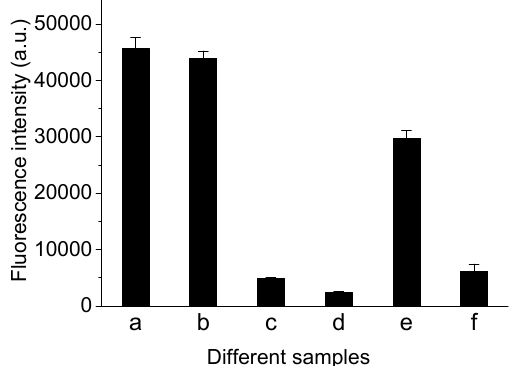
Figure 1. Fluorescence intensities of samples containing different reagents: ( a ) FDNA; ( b ) FDNA and BDNA; ( c ) MB; ( d ) MB and AFB1; ( e ) MB and cDNA and ( f ) MB, cDNA and AFB1. Concentrations of FDNA, BDNA and MB were 20 nM. Concentration of AFB1 was 500 nM. Excitation and emission wavelengths set for fluorescence measurements were 485 nm and 518 nm.